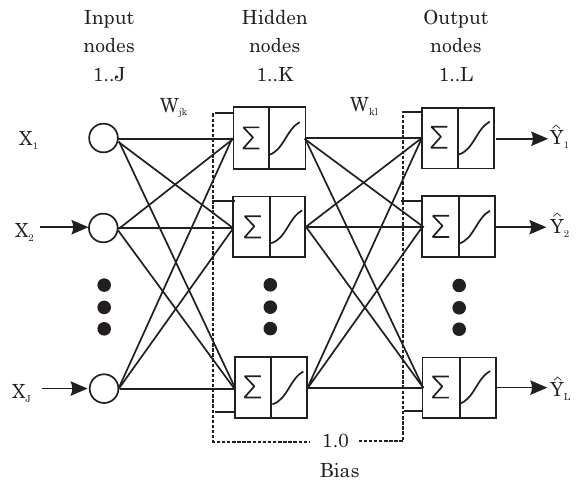
Figure 2. Schematic overview of a three-layer neural network. Source: Schaap & Leij